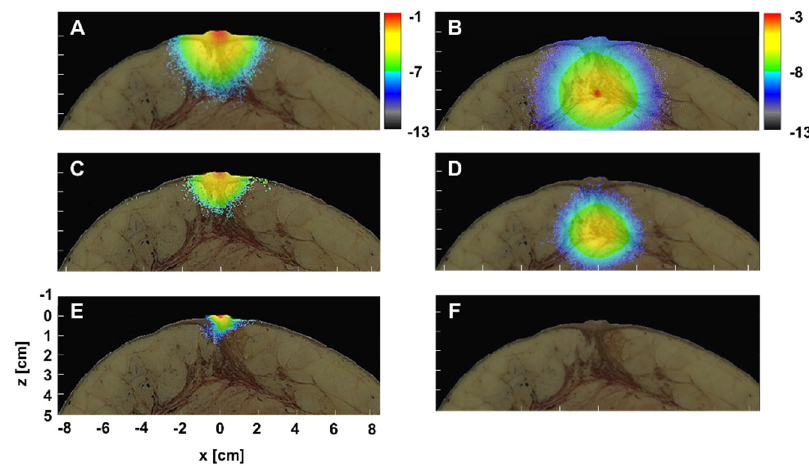
Figure 5. Fluence maps of photons associated with excitation ( A , C , E ) and emission ( B , D , F ) in the SWIR ( A , B ), the NIR ( C , D ), and the VIS ( E , F ). Fluorescence-labeled cancer with a diameter of 1 mm in the duct was embedded x = 0 at a depth of 3 cm. All maps share values on the x and z -axis of ( E ). ( A , C , E ) share the scale bar which shows the logarithmic scale in ( A ) and ( B , D , F ) share the scale bar in ( B ).